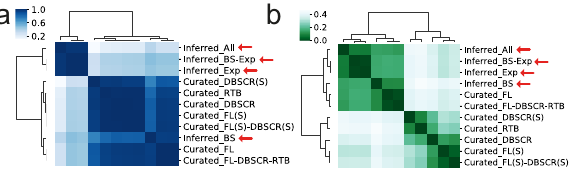
Figure 4. Network comparative by structural properties. ( a ) Pearson correlation of the profile of structural properties listed in Supplementary Figure 12. ( b ) D-value from Schieber et al . 43 to measure network similarity.